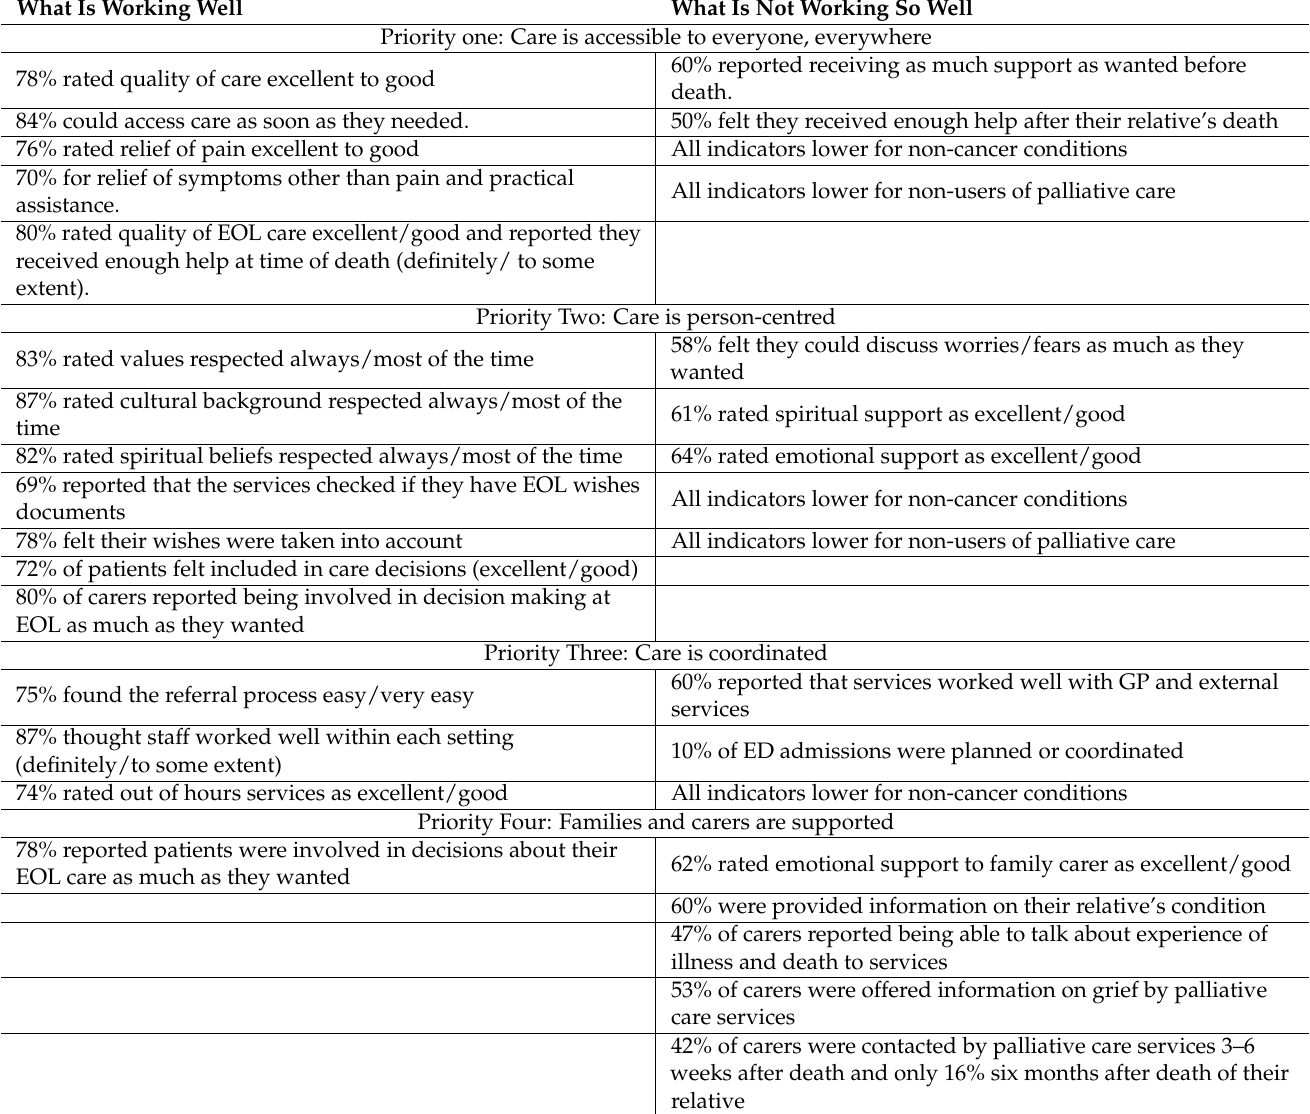
Table 3. Differences in quality indicators within the six